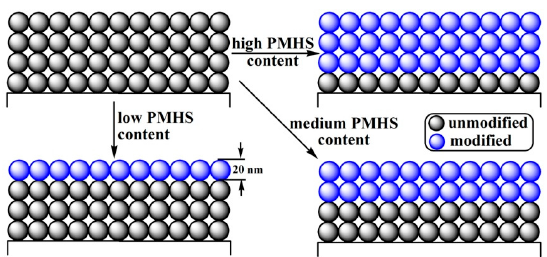
Figure 3. Schematic representation of F-PMHS modification at different F-PMHS